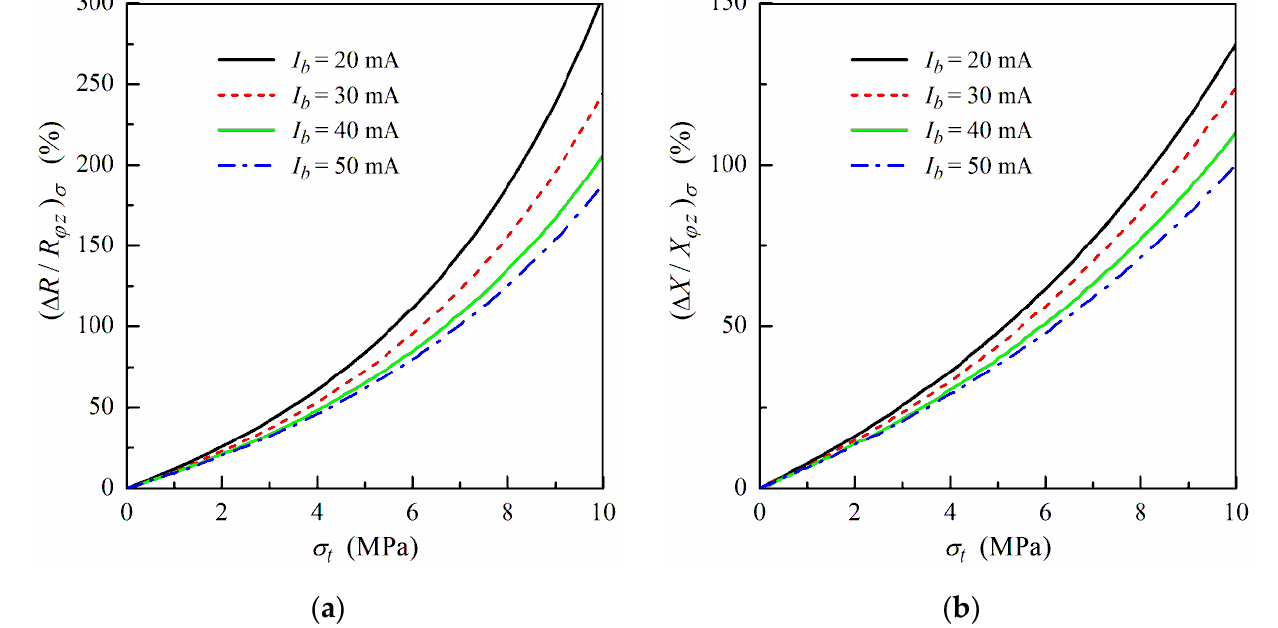
Figure 8. The ratio of ( ∆ R / R ϕ z ) σ ( a ) and ( ∆ X / X ϕ z ) σ ( b ) as a function of the tensile stress σ t at H e = 10 Oe and f = 100 MHz for different values of the bias current I b . Magnetostriction coefficient λ s = 40 × 10 − 6 , other parameters used for calculations are the same as in Figure 3.